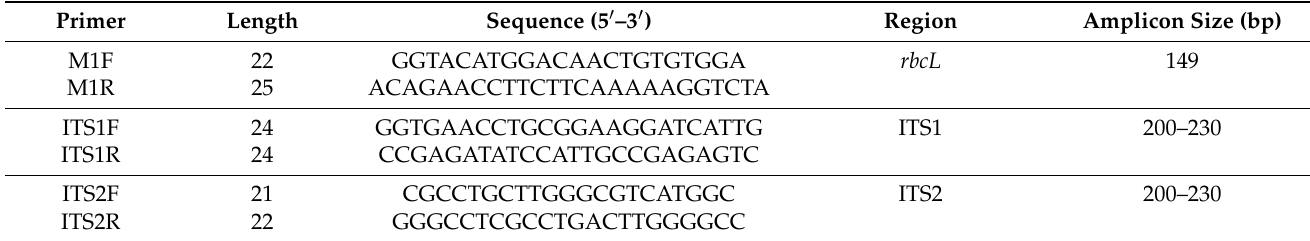
Table 2. Primers used in HRM assays.